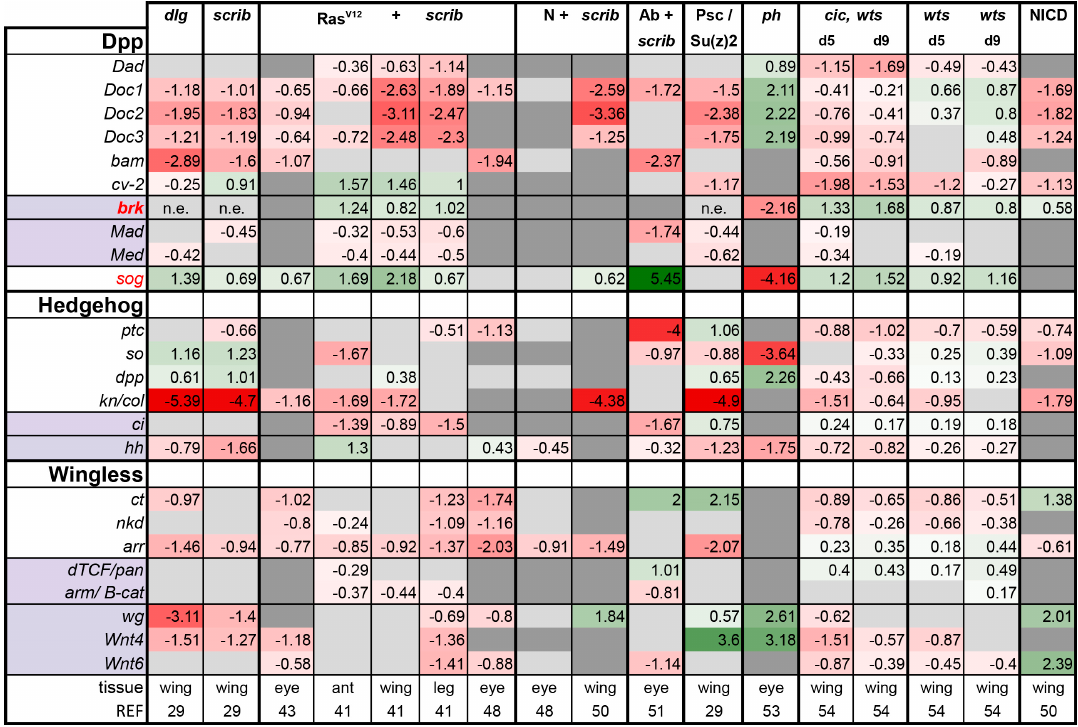
Figure 3. Tumors display a trend of overall suppression of Dpp, Hh, and Wg pathways. The target genes that are suppressed by the pathway are shown in bold, and pathway inhibitors are shown in red. Light purple highlights the transcription factors of each pathway. brk meets all three criteria. In the case of the Hh and Wg pathways, the ligands are also shown and highlighted in light purple, their expression is not necessarily regulated by their own pathway, but their excess production can activate their respective pathway. dpp is a transcriptional target of Hh signaling and is shown in that section. Gene expression is displayed in log2FC. Color coding corresponds to a heatmap with a scale from − 5 (dark red, downregulation) to 5 (dark green, upregulation). Light grey cells represent non-significant changes with p ≥ 0.05. Dark grey: the gene was not found in the dataset. n .e. = not expressed, the gene was in the data, but showed 0 reads. Abbreviations: Daughters against Dpp, Dad; Dorsocross 1-3, Doc1-3; bag of marbles, bam; crossveinless-2, cv-2; brinker, brk; Mothers against Dpp, Mad; Medea, Med; short gastrulation, sog; knot, kn; collier, coll; cut, ct; naked, nkd; arrow, arr; Drosophila T cell factor, dTCF; pangolin,